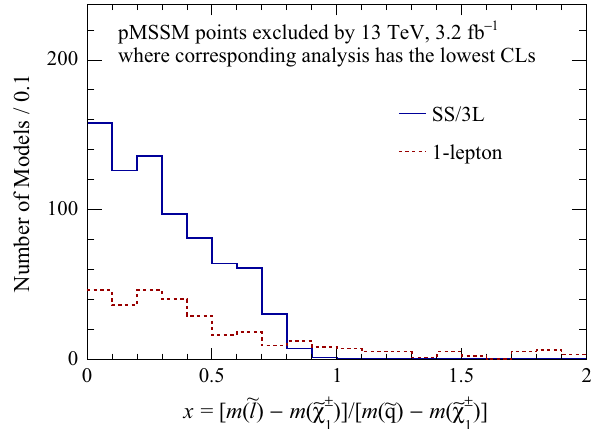
Fig. 6 Distribution of mass splitting for the chargino–slepton–squark ˜ χ ± – ˜ (cid:4) – ˜ q system, parametrised by x as defined in Eq. 2. These are pre- 1 sented for the excluded points where the 1-lepton ( dashed red ) and SS/3L ( solid blue ) analyses are most